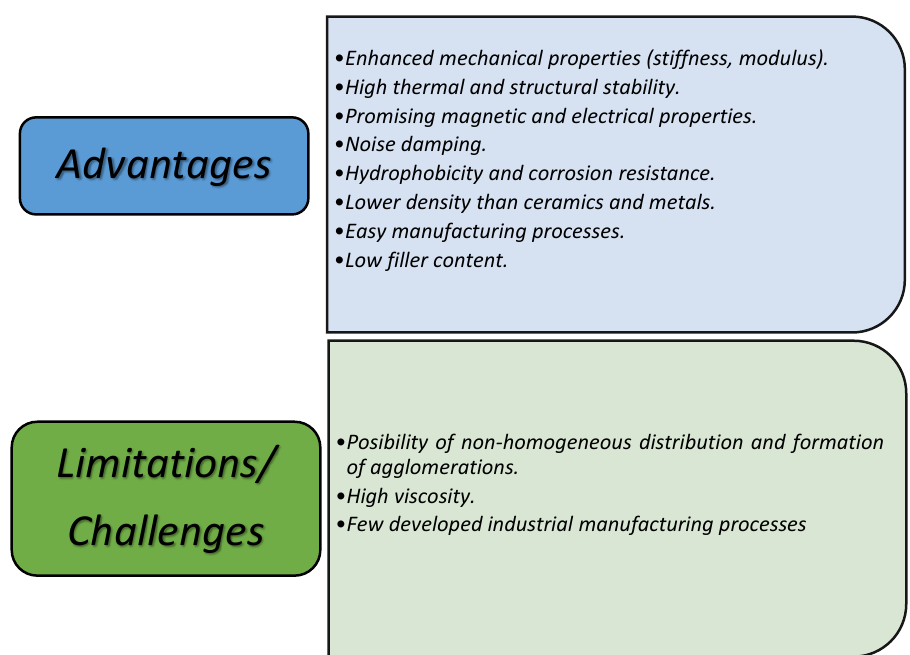
Figure 1. Advantages and limitations of polymer nanocomposites.